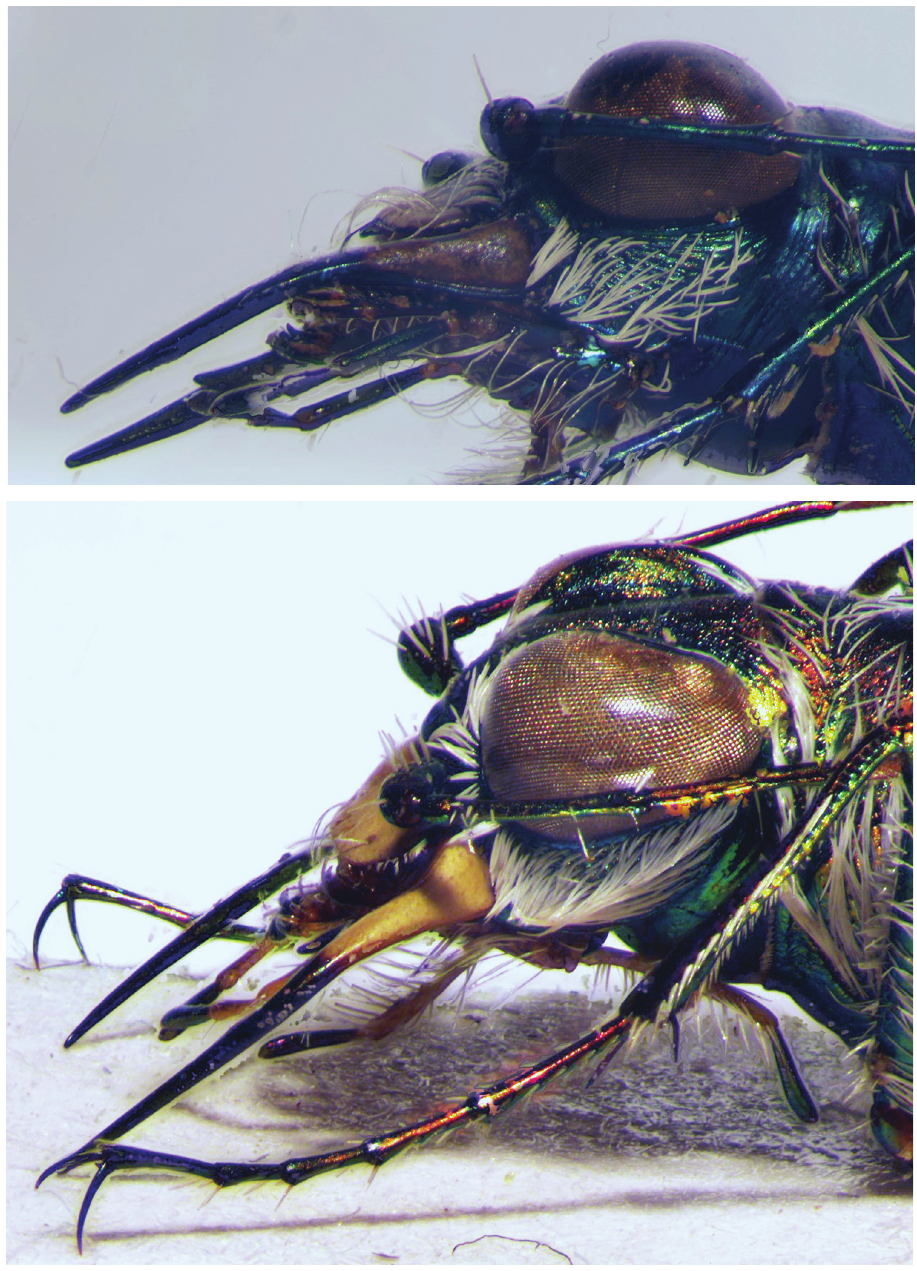
Figure 48. Head in lateral view: Calomera alboguttata (above) and Habrodera nilotica